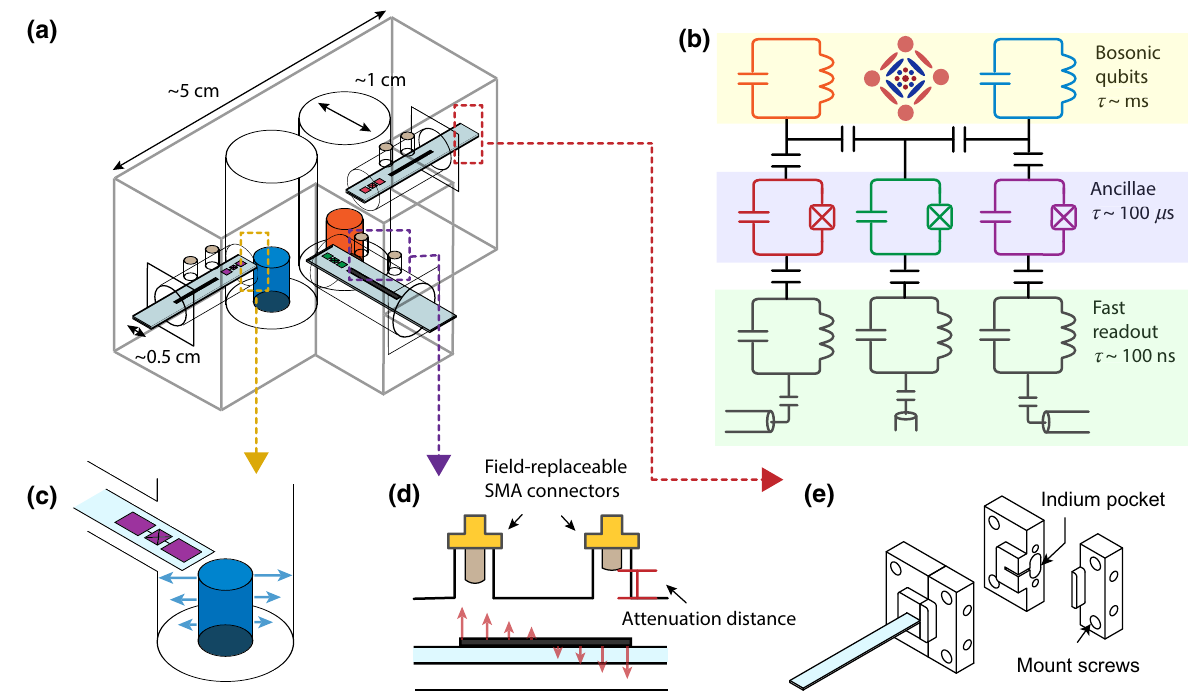
FIG. 5. Main elements in 3D cQED devices . (a) A sample device consisting of two 3D cavities (blue and orange), three transmon ancillae (purple, green, and red) together with their respective planar readout resonators (gray). All components are housed in a high- purity aluminium package. (b) The equivalent circuit representation of the device. (c) A more detailed illustration of the transmon and cavity interface. The coupling strength between the two is determined by the overlap between the transmon capacitor and the field (blue arrows) of the cavity. (d) Cross-section view of the coupling mechanism to the transmon and the readout resonator via field-replaceable pins. (e) Schematic of the clamping structure for chips containing the transmon and its readout